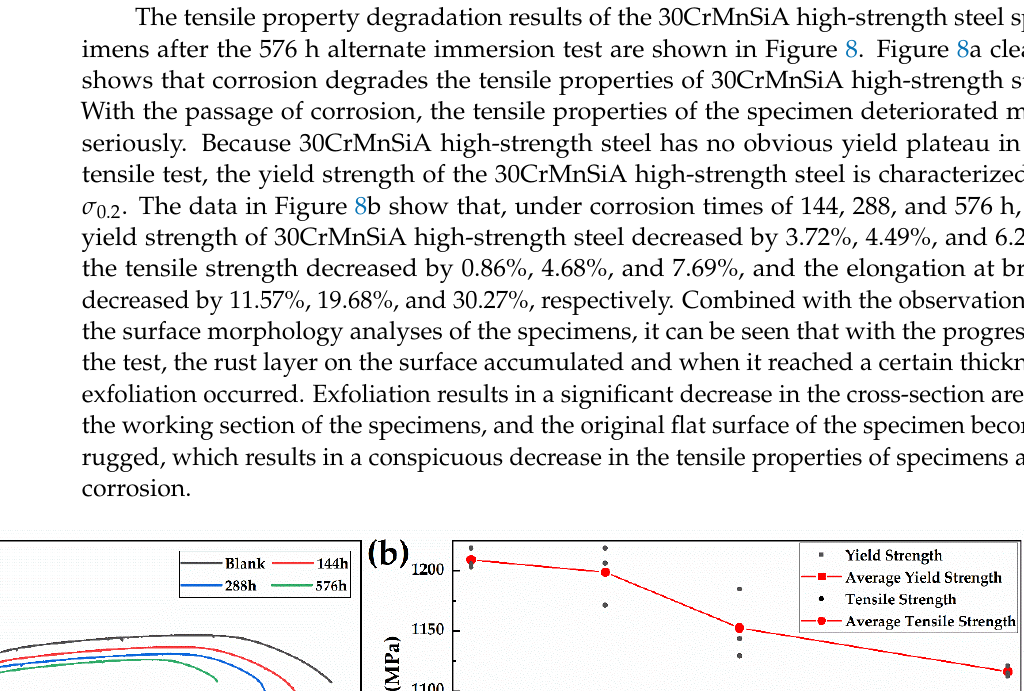
Figure 9. Fatigue life of 30CrMnSiA steel after the 576 ‐ h alternate immersion test.